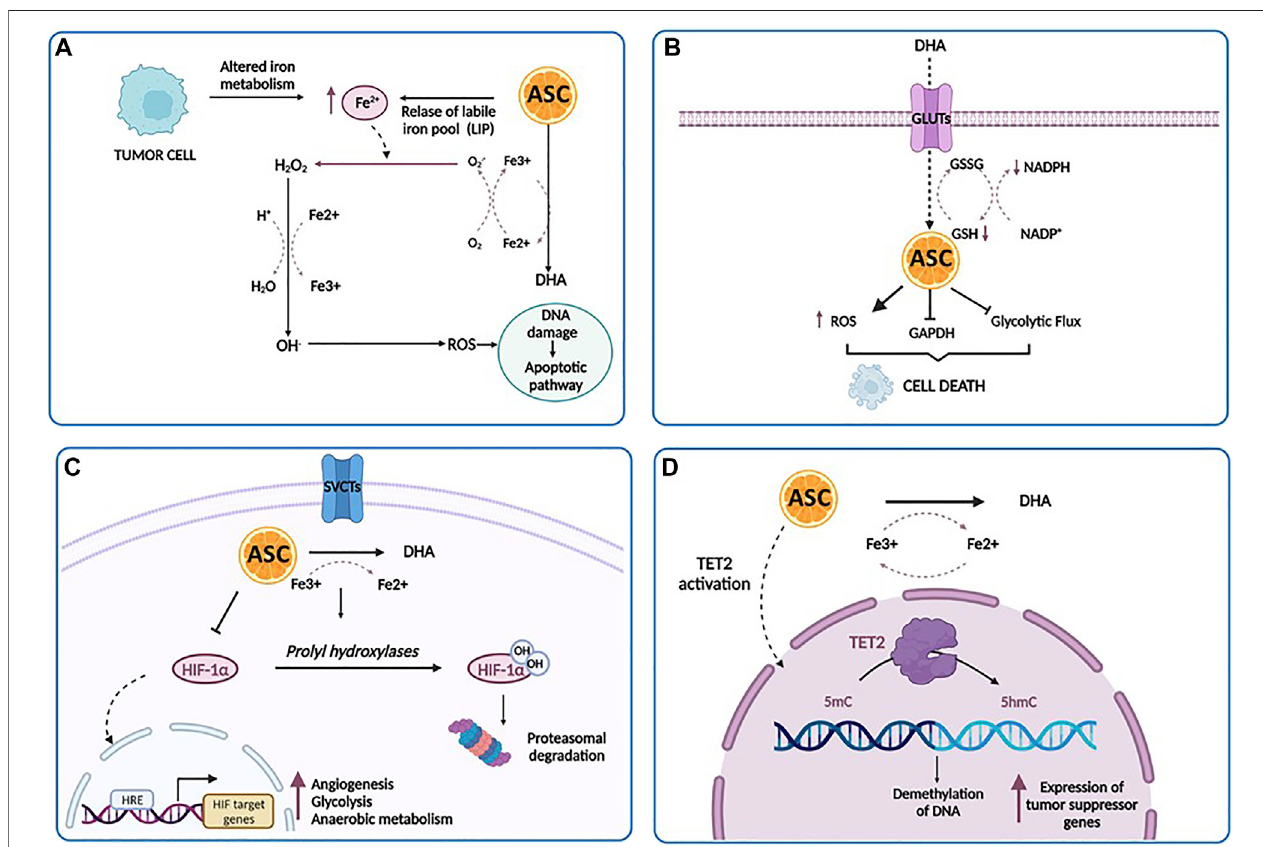
FIGURE 3 | The anti-cancer effects of ascorbic acid. (A) A high concentration of ascorbic acid (ASC) increases the labile iron pool (LIP) of tumor cells, induces the productionofincreased levelofROSdirectlydamagingmitochondriaand DNA,and ultimately stimulatesapoptotic pathways. (B) TumorcellscanuptakeDHA athigher rates and then internally reduce it to ASC. This reduction triggers scavenging of glutathione (GSH), inducing oxidative stress, the inactivation of glyceraldehyde 3- phosphatedehydrogenase(GAPDH),theinhibition ofglycolytic fl ux, anenergycrisis andcelldeath. (C) Inthehypoxicconditionsoftumor microenvironment,there is a repression of HIF-1 α hydroxilation. As a result, HIF-1 α accumulates in the cytoplasm and translocates into the nucleus, promoting the transcription of its targets involved in prcesses such as angiogenesis, glycolysis and anaerobic metabolism, metastasis and resistance to therapy. Under ascorbic acid treatment, HIF-1 α is hydroxylated by the prolyl hydroxylases, ultimately leading to polyubiquitination and proteasomal degratadion of HIF-1 α . (D) Ascorbic acid binds to the catalytic domain of TET and facilitates DNA demethylation and re-expression of important tumor suppressor genes. Created with Biorender.com.